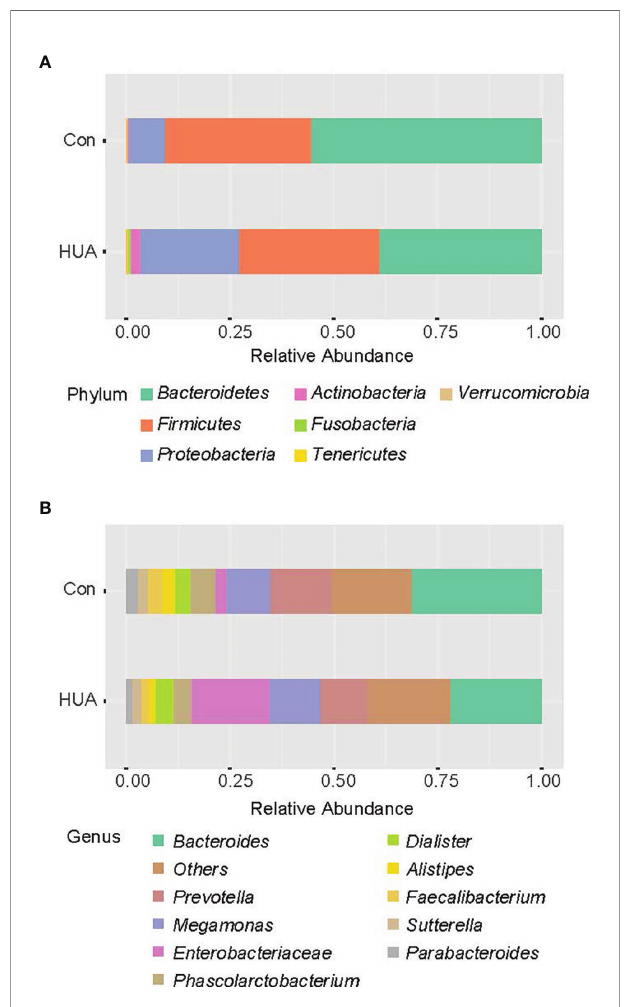
FIGURE 2 | Bar chart representing Mann – Whitney U -test results on OTUs grouped in phyla (A) and in genus (B) of the HUA and Con subjects (showing top 10 taxa). HUA, hyperuricemia; Con, control.